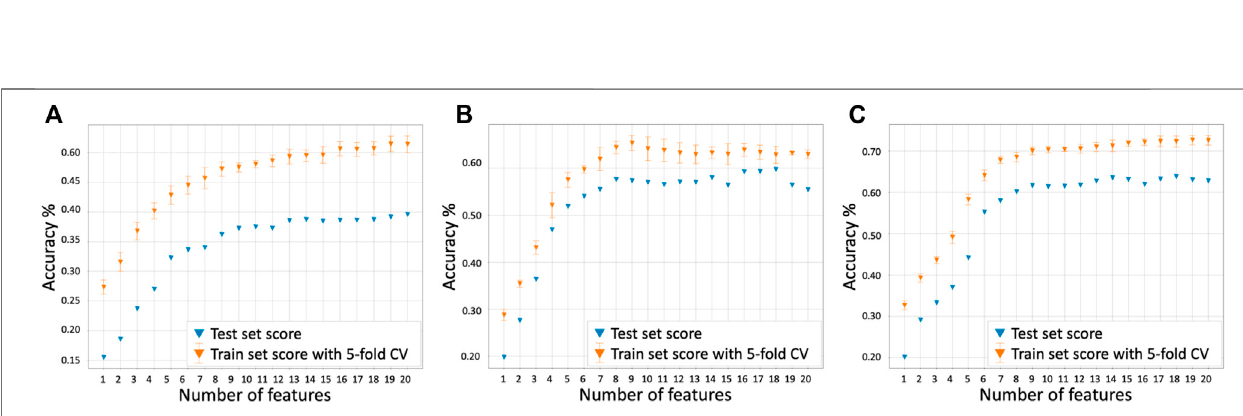
Frontiers in Signal Processing |